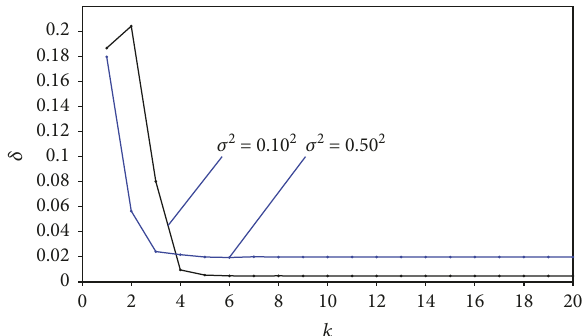
Figure 1: The parameter estimation errors δ versus k (E-NI).